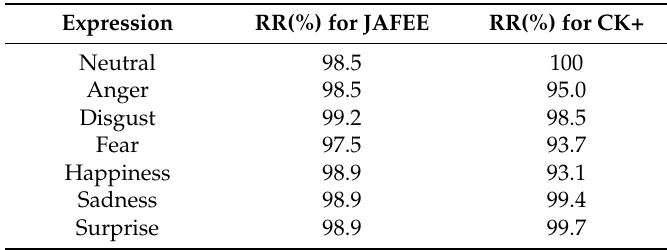
Table 7. Results with the application of